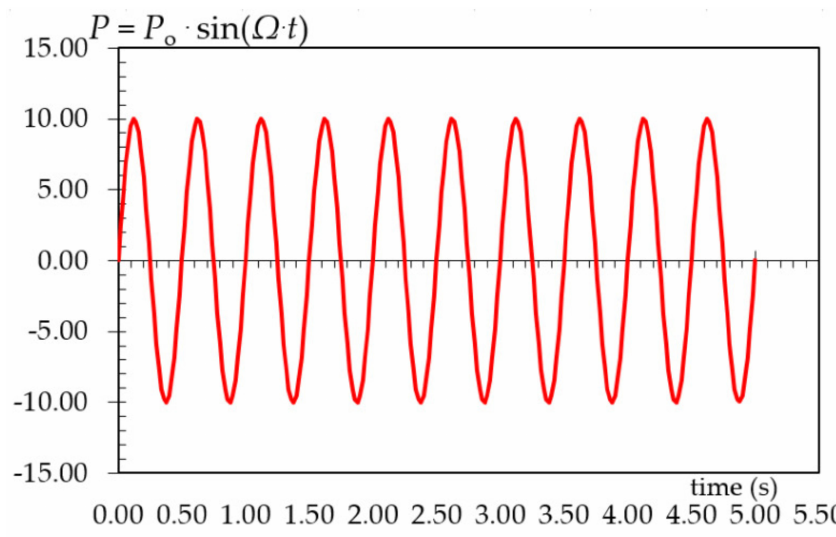
Figure 5. Graph of sinusoidal